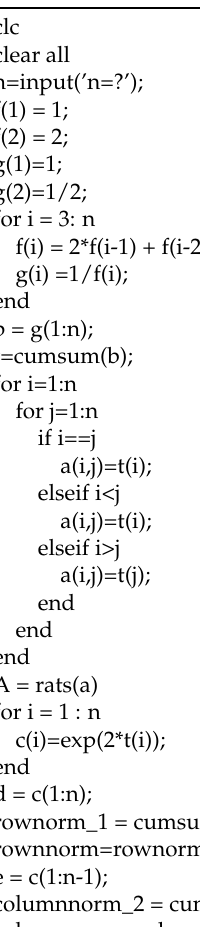
Table 2. MATLAB-R2016a code for the matrix P and for the norm calculations of e ◦ P